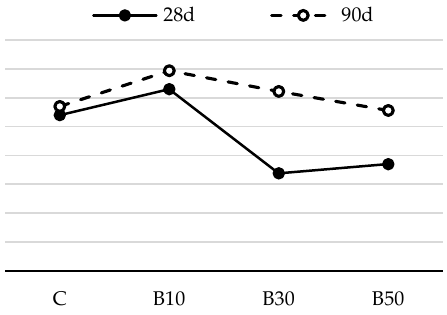
Figure 5. Flexural strength of mortars blended with biomass ash.